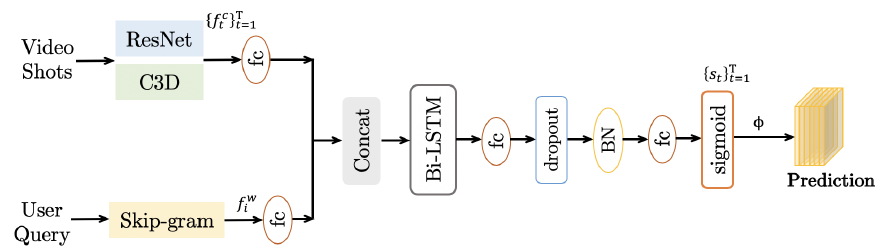
Figure 4. The pipeline for the inference phase. Given a video and a certain user query, the predicted scores are generated using SummNet without the MapNet and the reinforcement learning rewards. A threshold φ is applied to the raw scores to achieve binarized summary